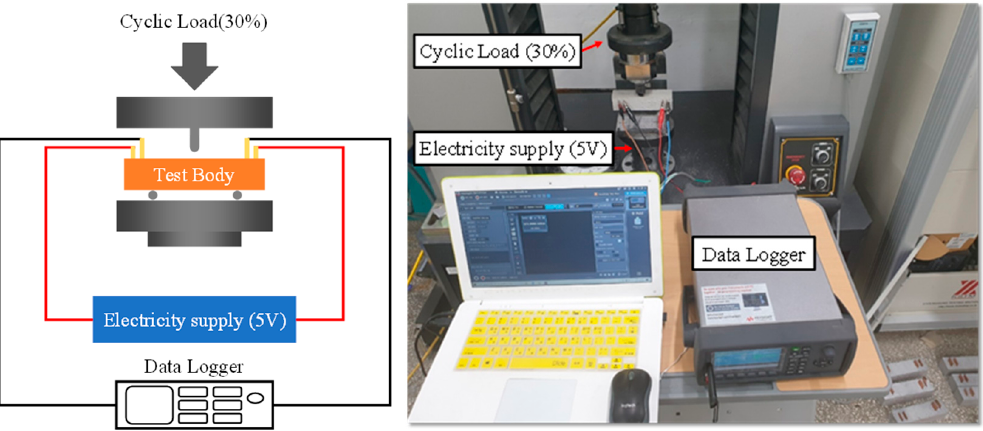
Figure 5. Schematic of fractional change in resistance measurement during cyclic loading.